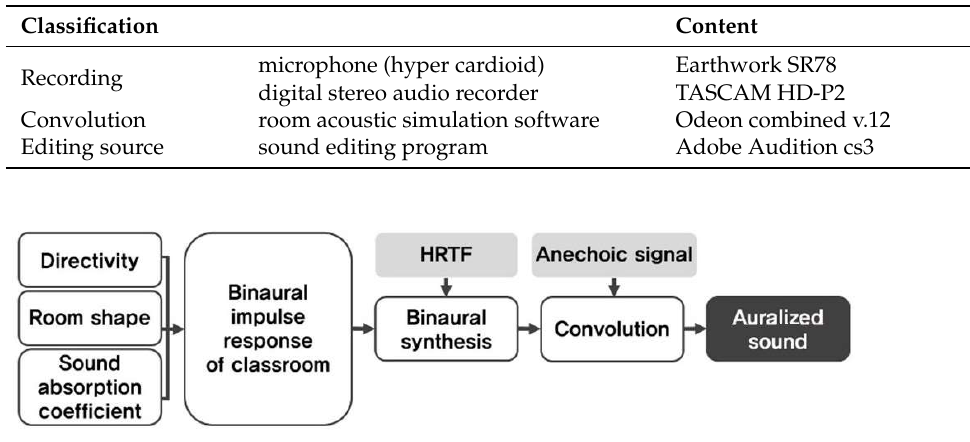
Figure 4. Flow diagram of the auralized sound production.